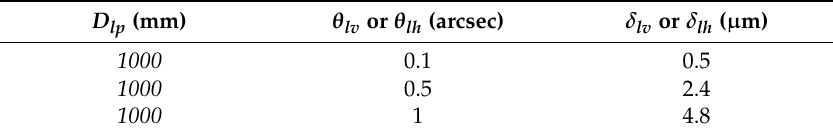
Table 1. Error analysis of the laser source at vertical or horizontal